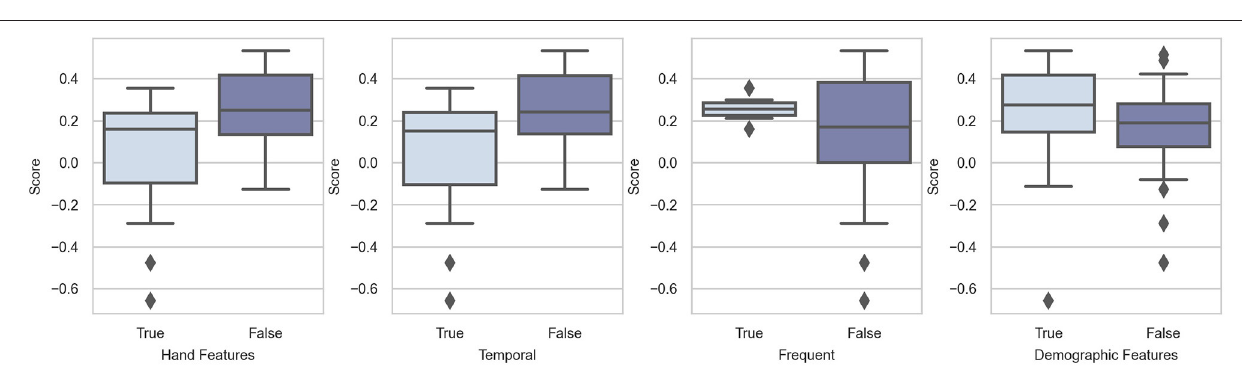
FIGURE 4 | Box-plots of score distributions of feature engineering